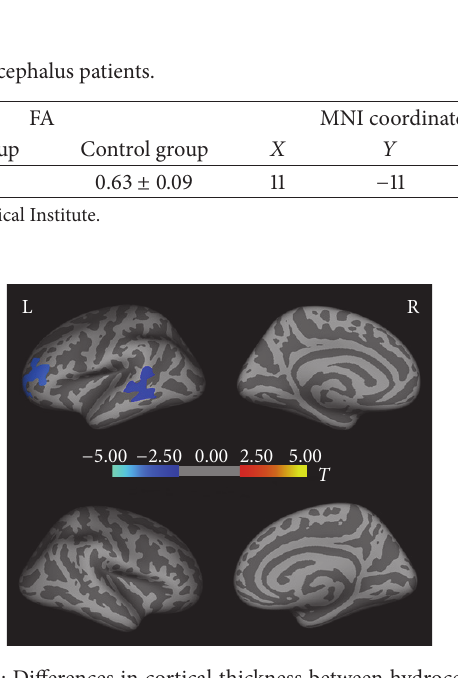
Figure 1: Differences in cortical thickness between hydrocephalus group and control group. Significance was determined by Monte Carlo simulation. Less cortical thickness in hydrocephalus group than in control group is indicated by blue/cool color. 𝑃 < 0.05 . L: left hemisphere. R: right